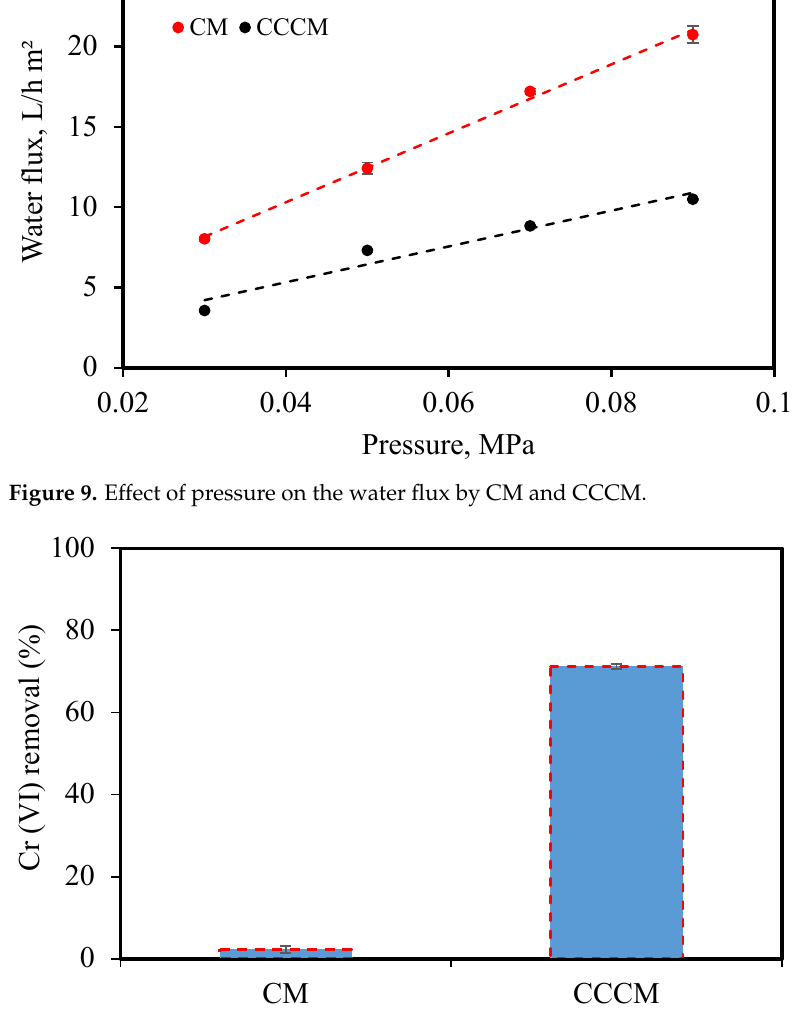
Figure 10. The performance of the CM and CCCM in the removal of Cr(VI).